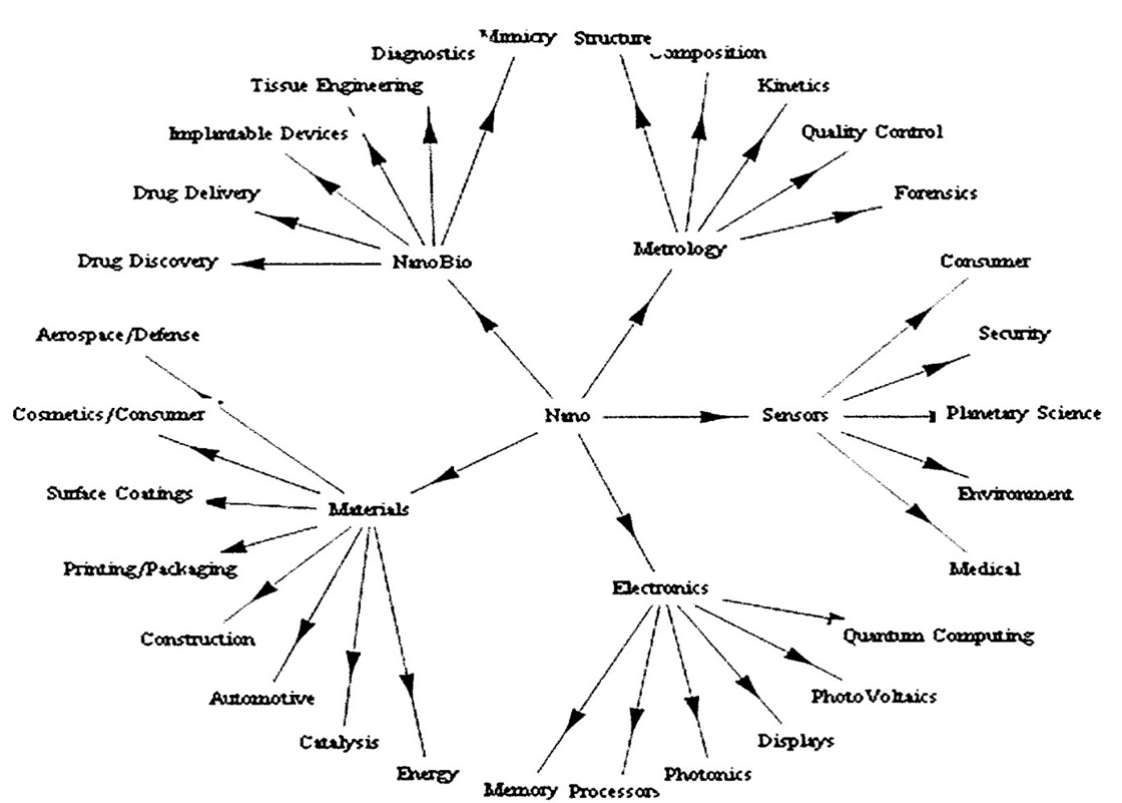
Figure 1. Schematic of nanotechnology application areas. (Source WikiMedia Commons, P. Fraundorf, distributed under the Creative Commons Attribution-Share Alike 3.0 Unported